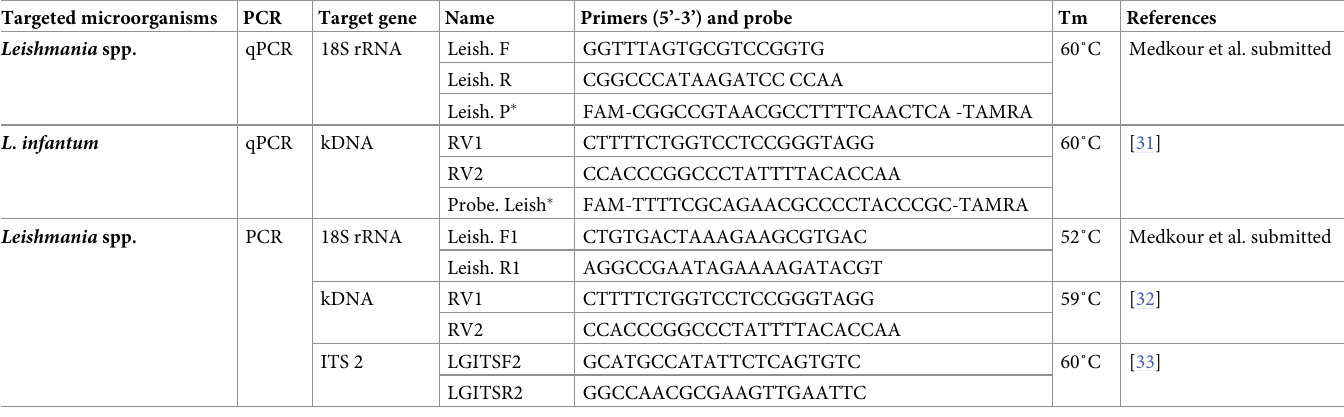
Table 1. Sequences of primers set used for Leishmania detection and species